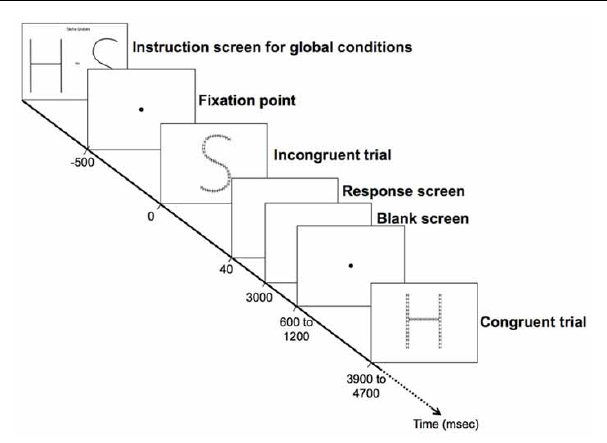
FIGURE 2 | Experimental design. Each trial began with a central fixation point that lasted 500ms. This fixation time was followed by the presentation of the compound stimuli, which was displayed for 40ms on a black screen. The participants had to respond as quickly and accurately as possible by pressing a mouse button to report which of the two targets (“H” or “S”) they detected at the corresponding level. The response time (RT) was limited to 3000ms (black screen). The inter-stimulus interval (ISI) was jittered between 600 and 1200ms (black screen). All screens were black with white text or figure.